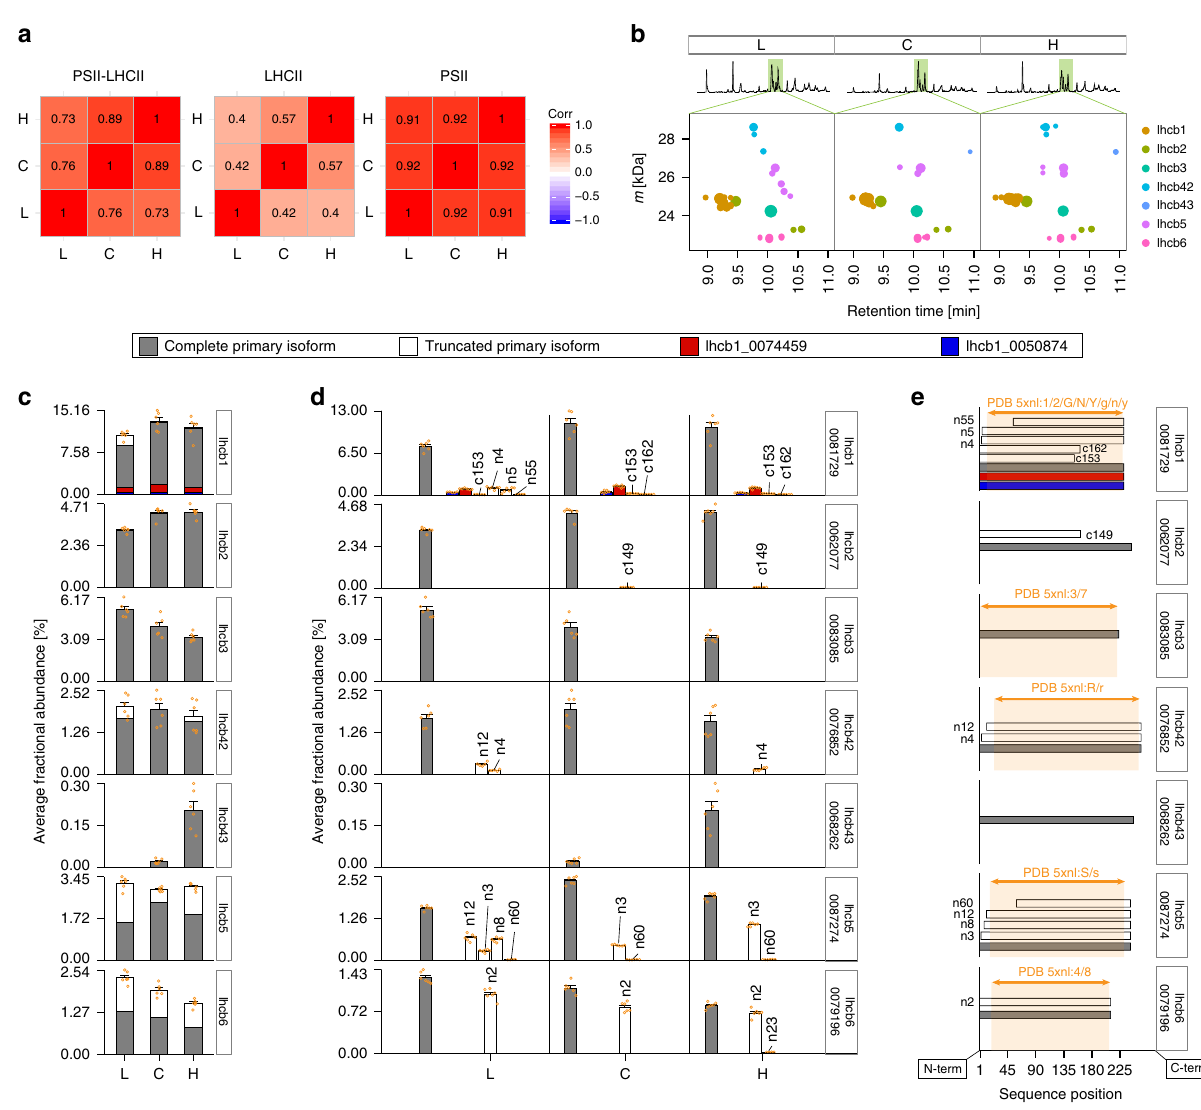
Fig. 2 TD-MS pro fi ling of LHCII diversity. a Spearman correlation of mass features detected in the PSII – LHCIIsc L, C and H samples for PSII – LHCIIsc (left), LHCII (middle), and PSII (right) proteins. b Region of the LC – MS chromatogram corresponding to the elution of LHCII proteoforms displayed as assigned mass features versus retention time (see Supplementary Fig. 1 for overview of all proteins detected in TD-MS). c Average abundances of LHCII proteins and d detailed average abundances of the distinct isoforms and proteoforms for each LHCII protein, accession number of the primary isoform is reported in the box on the right (see Supplementary Fig. 3 for quanti fi cation of distinct proteoforms detected in TD-MS). Error bars represent standard error of the mean abundance for each proteoform. e Schematic representation of sequence alignment of LHCII isoforms and proteoforms detected in TD-MS analyses and corresponding sequences resolved in the high-resolution structure of the PSII – LHCII supercomplex from pea plants (PDB: 5xnl, and chains therein; the orange box highlights the portion of protein sequence with resolved